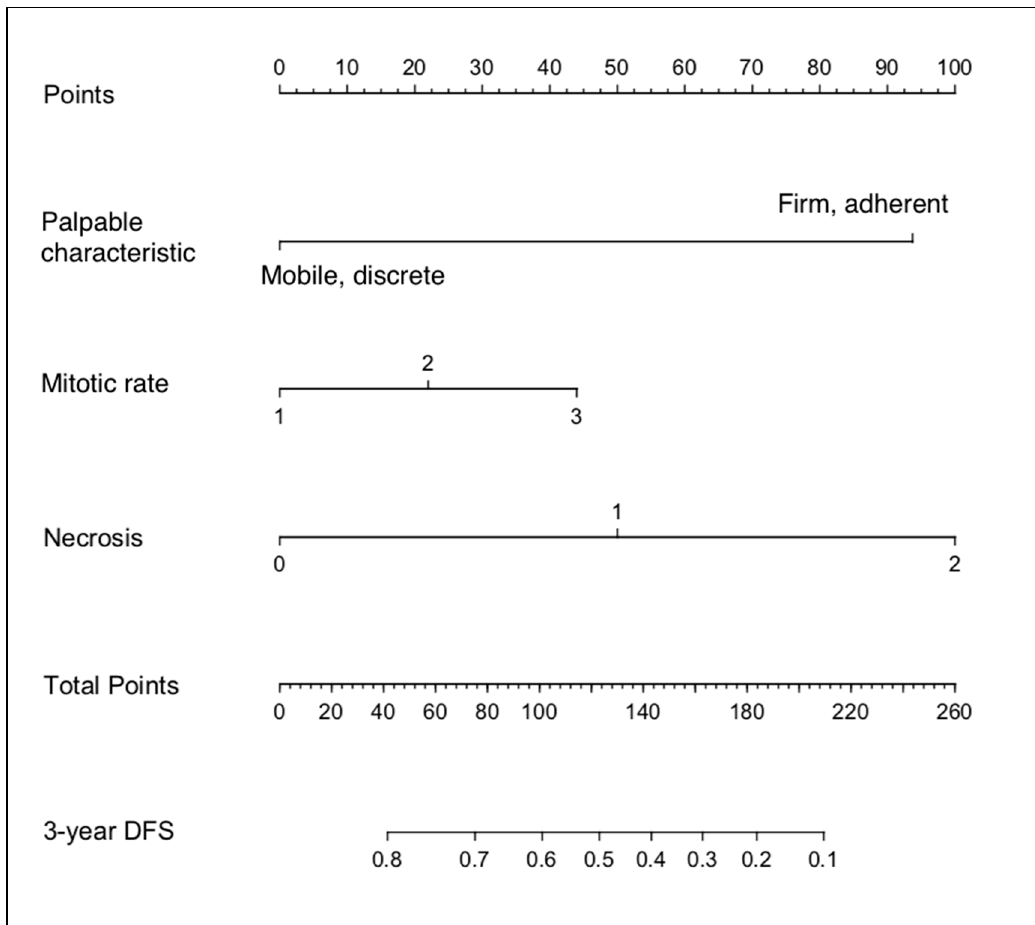
Figure 1. Nomogram developed from the Clinical_train dataset.